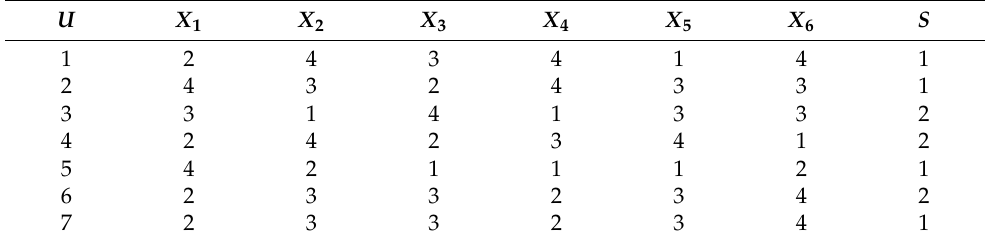
Table 3. The information table of enterprise B 2